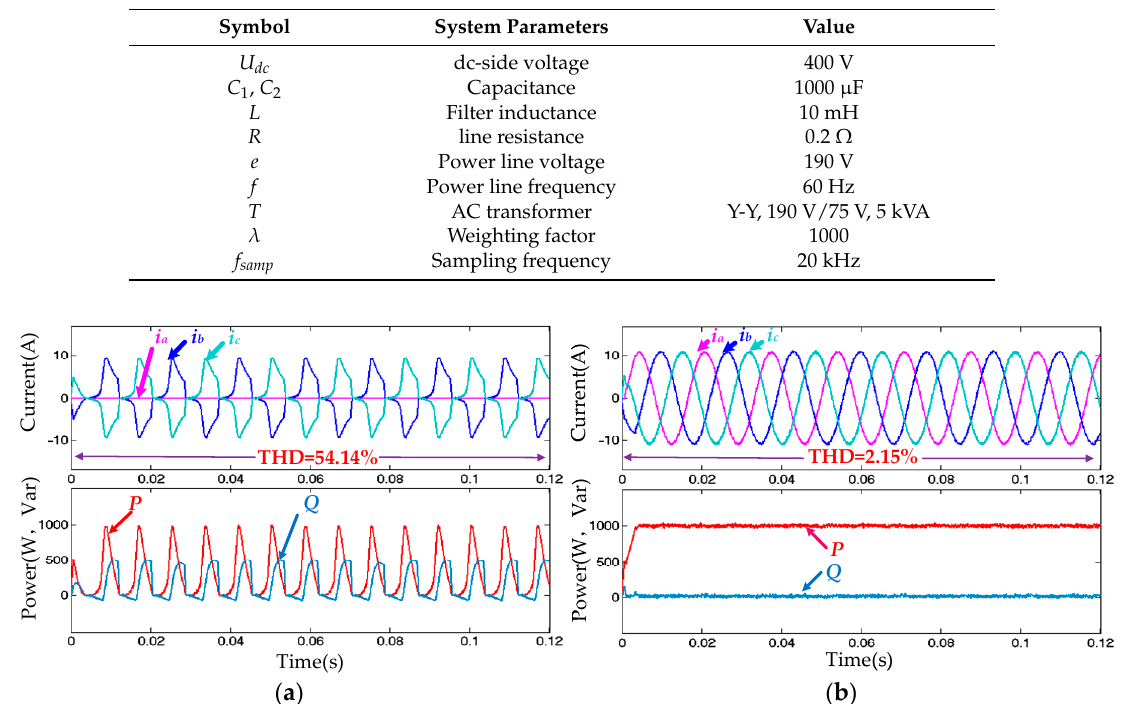
Figure 7. Simulation results of MPDPC in inverter mode with leg faults of phase a. ( a ) Traditional BVSC; ( b ) Proposed MPDPC for fault-tolerant BVSC.